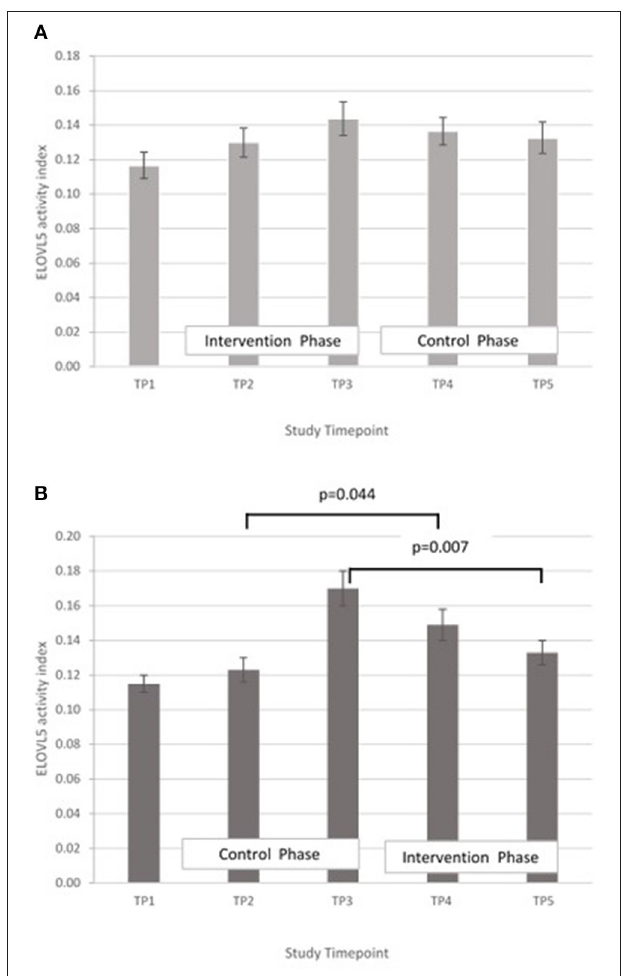
FIGURE 8 | (A) Elongase-5 activity measured in Group A at baseline (T1), week 4 of period 1 (T2), week 8 of period 1 (T3), week 4 of period 2 (T4) and week 8 of period 2 (T5). Bars indicate estimated marginal means with standard error. (B) Elongase-5 activity measured in Group B at baseline (T1), week 4 of period 1 (T2), week 8 of period 1 (T3), week 4 of period 2 (T4) and week 8 of period 2 (T5). Bars indicate estimated marginal means with standard